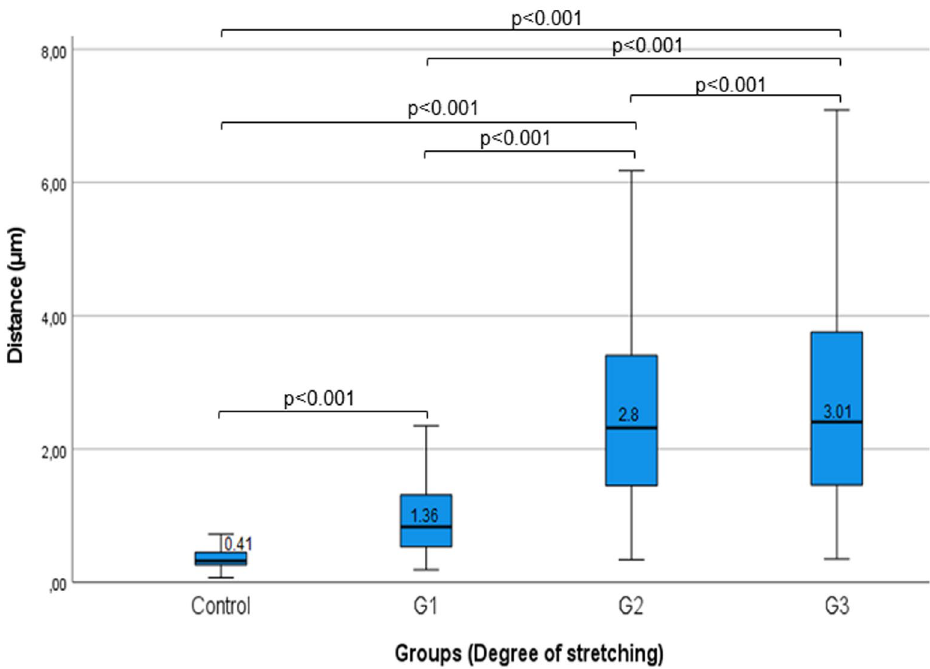
Figure 6. Distance between muscle cells. Boxplot diagram showing the measured distance between cells in the four Groups and the observed significant difference by paired comparisons of the